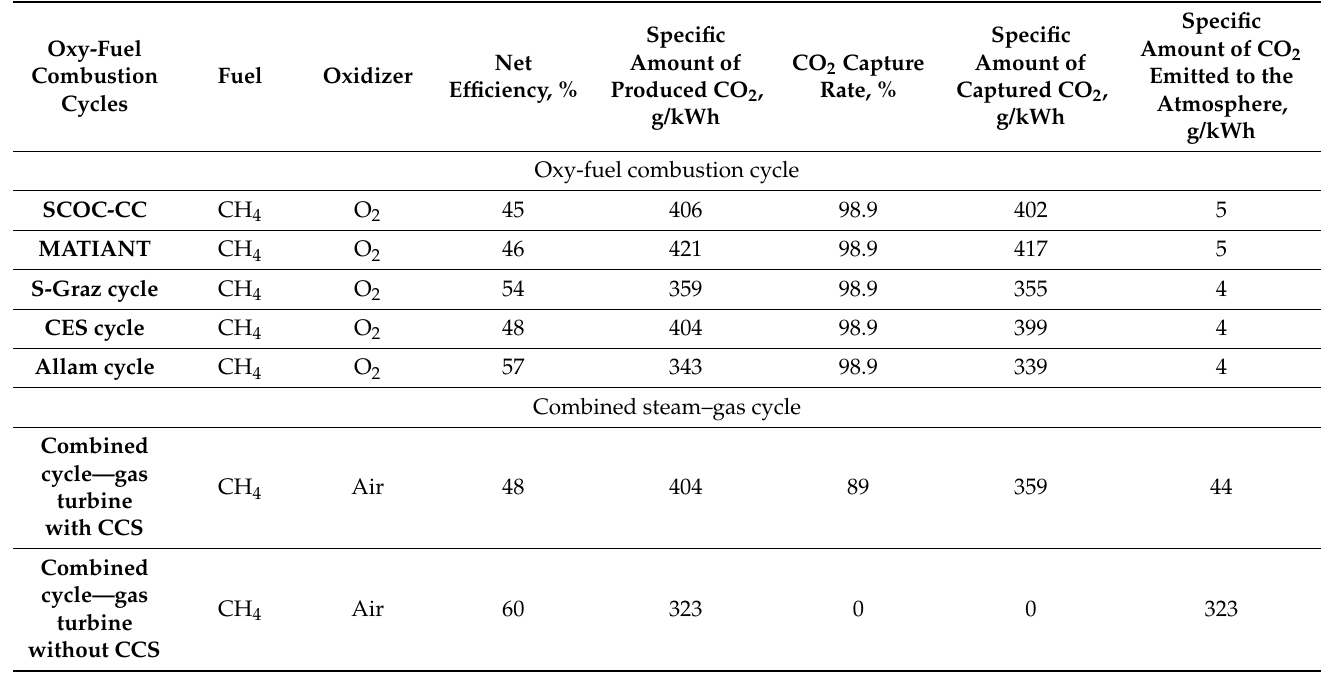
Table 2. Oxy-fuel cycle performances compared against those of combined